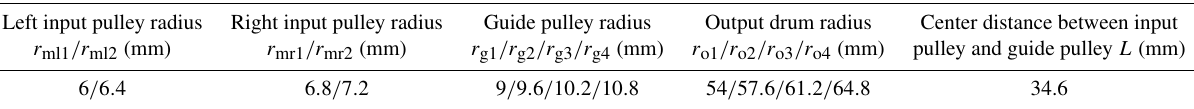
Table 2. The geometric parameters of the developed MBCDM. Left input pulley radius Right input pulley radius Guide pulley